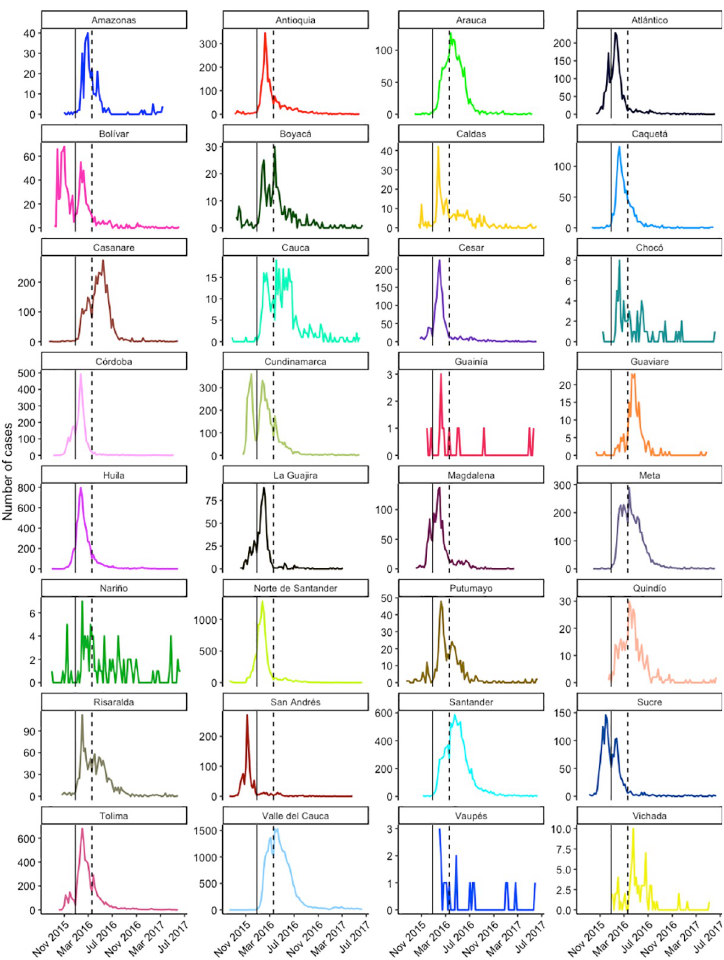
New Year’s Day in 2016 (epidemiological week 52). Y-axes are different, and x-axes are the